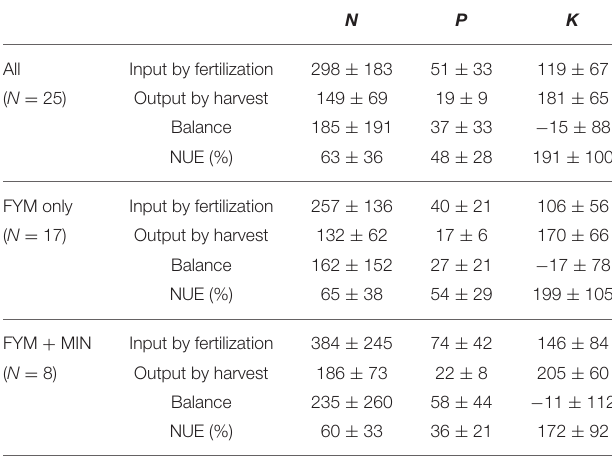
TABLE 6 | Nutrient soil surface balance and nutrient use efficiency (NUE).